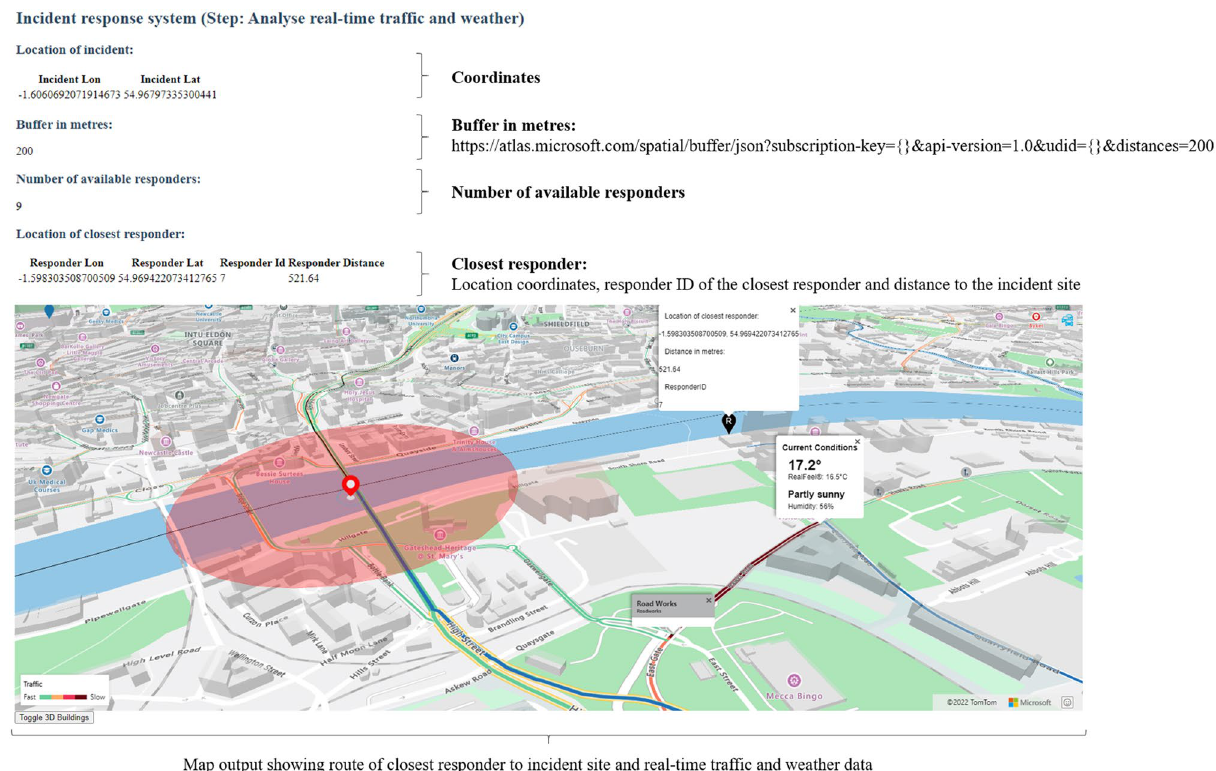
Figure 5. Incident process steps 4–6: Route navigation from closest responder to incident site using real- time traffic and weather data (own figure). The web application shows the indicators: Location of incident (longitude, latitude); buffer in metres; the number of available responders; and the location of the closest responder (responder longitude and latitude, responder ID, responder name and distance to the incident site). The map output visualises the location of the incident on the Tyne Bridge with a red marker and a red circular buffer area around the incident location. The black marker with the white letter "R" near the river indicates the closest responder to the incident site. The blue-marked road indicates the route in the network leading from the location of the responder to the incident site. The road network shows the traffic flow using the color ramp from green (fast) to red (slow). The pop-up windows show the current weather and road network conditions. KW created the map output using the Microsoft Azure Maps Web Software Development Kit and TomTom ( © 2022) base map data (a subscription key to use the data can be obtained after registering on the Azure Maps platform for Geospatial Mapping APIs under https:// azure. micro soft. com/ en- us/ servi ces/ azure- maps/# azure maps- overv iew). The code for the web application was developed in JavaScript, CSS and HTML in the Microsoft Visual Studio Code integrated development environment (version 1.70.2) and Node.js (version 16.13.2) on a Windows NT 64-bit operating system (×64-based processor) 40.